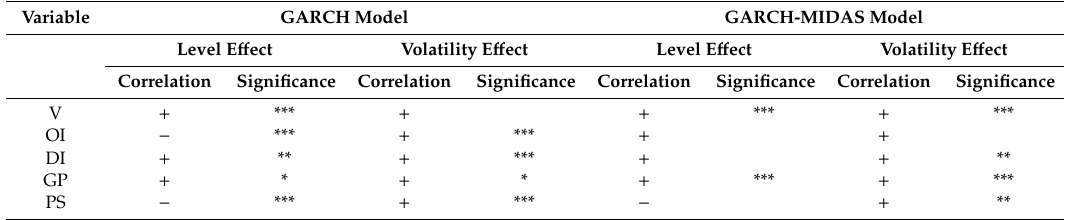
Table 15. Comparison of estimation results between GARCH model and GARCH-MIDAS model. Variable Correlation Significance Correlation Significance Correlation Significance Correlation Significance